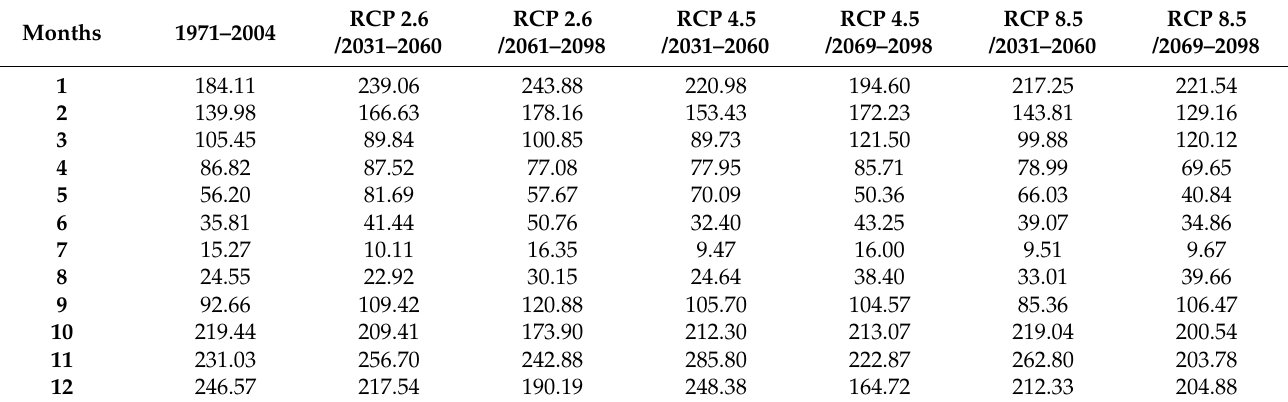
Table 3. Average monthly precipitation values for the reference period and climate